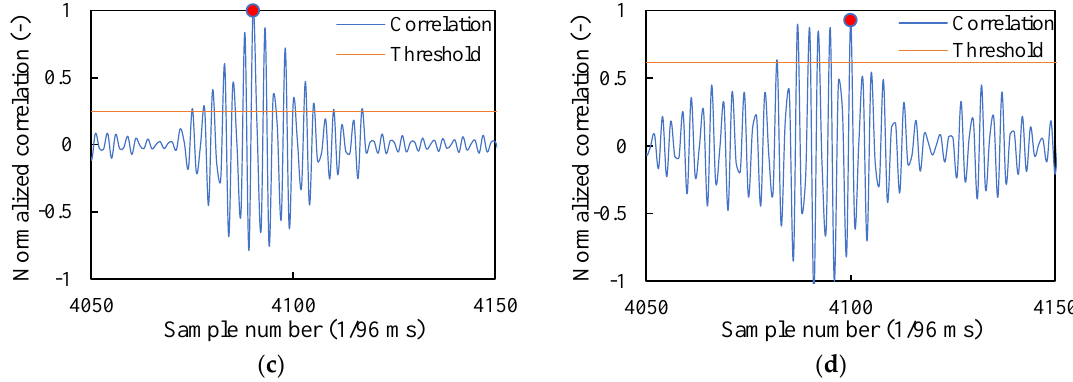
Figure 12. Correlation of the TDMA ( a , b ) and FDMA ( c , d ) signals with the non-operating quadcopter ( a , c ) and operating quadcopter ( b , d ).